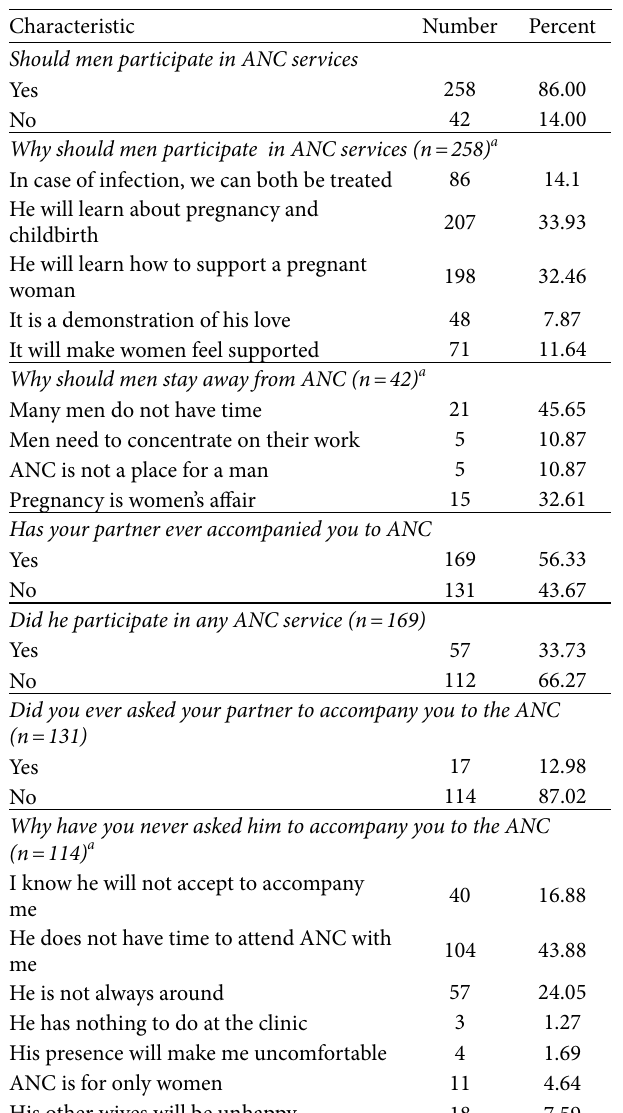
Table 2: Women’s perspective on male involvement in antenatal